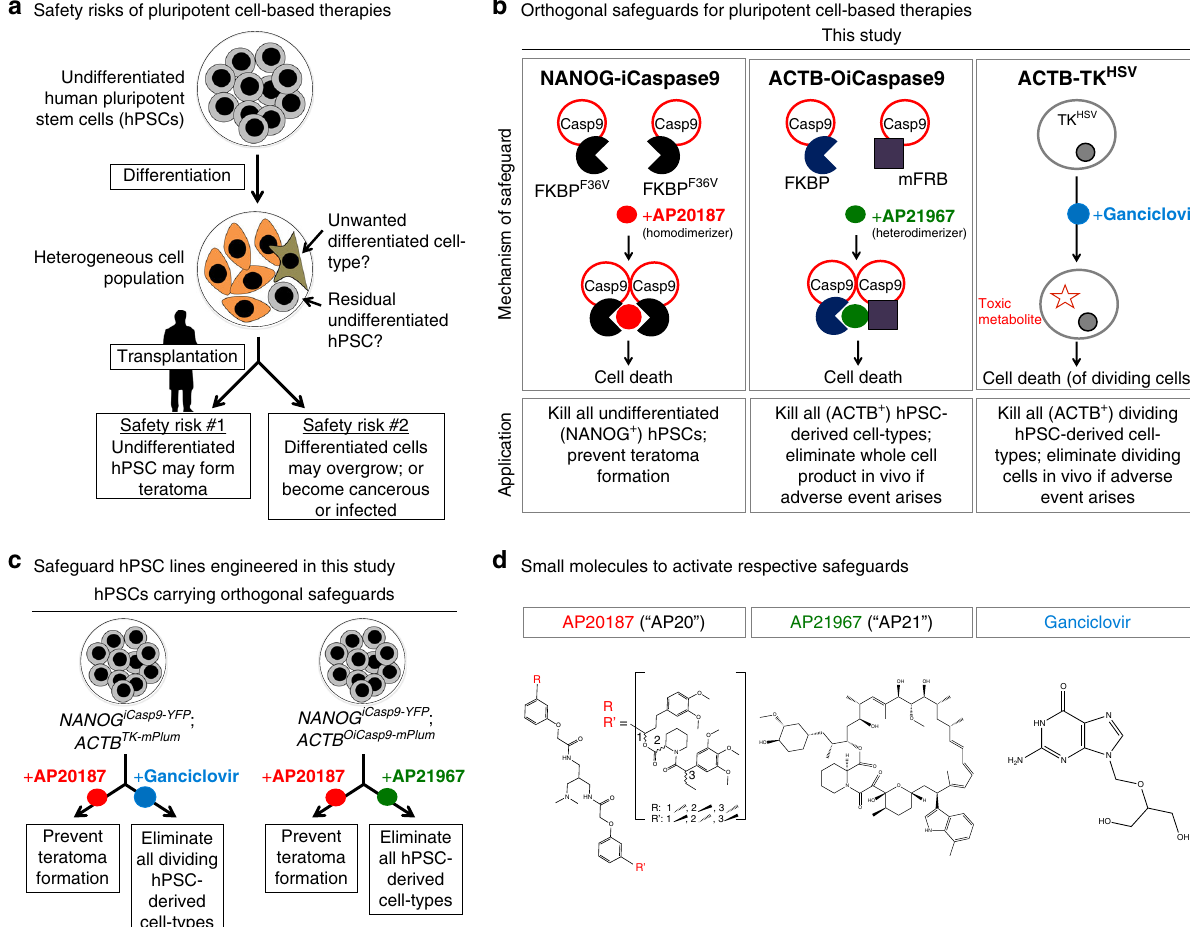
Fig. 1 Genetically engineered safeguards for human pluripotent stem cell-based therapies. a Safety risks of human pluripotent stem cell (hPSC)-based cell therapies. b Summary of the safeguards described in this study. iCaspase9 inducible Caspase9, OiCaspase9 orthogonal inducible Caspase9, TK HSV herpes simplex virus-derived thymidine kinase, FKBP F36V FKBP12 with F36V point mutation, mFRB mutant FRB domain. c Applications of the safeguards described in this study. d Small molecules used to activate respective